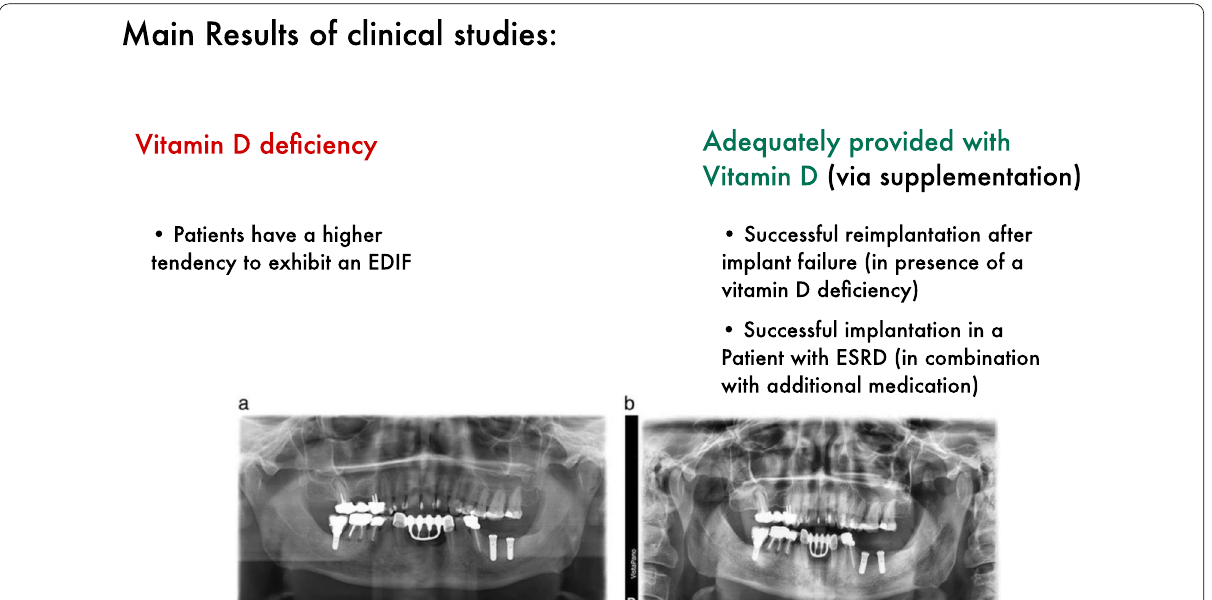
Fig. 4 Overview concerning the main results of clinical studies. ESRD: End‑stage renal failure, EDIF: Early dental implant failure. Including orthopantomogram pictures published by Fretwurst et al. 2016 (https:// link. sprin ger. com/ conte nt/ pdf/ 10. 1186/ s40729‑ 016‑ 0056‑0. pdf), no changes have been made to the figure. Copyright © Tobias Fretwurst, Sebastian Grunert, Johan P. Woelber, Katja Nelson and Wiebke Semper‑Hogg (http:// creat iveco mmons. org/ licen ses/ by/4.